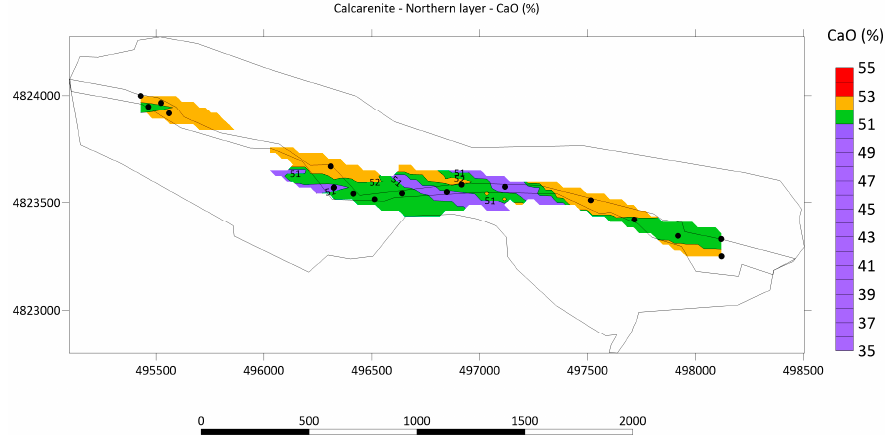
Figure 12. Map of CaO (%) in unit (5), northern layer (boreholes are black dots).